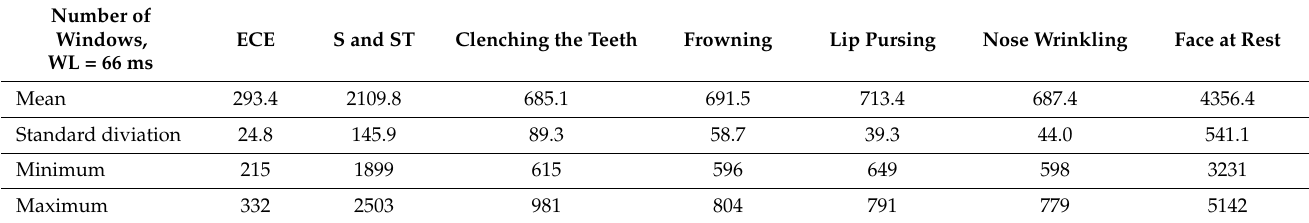
Table 1. Information regarding absolute amount of data available per